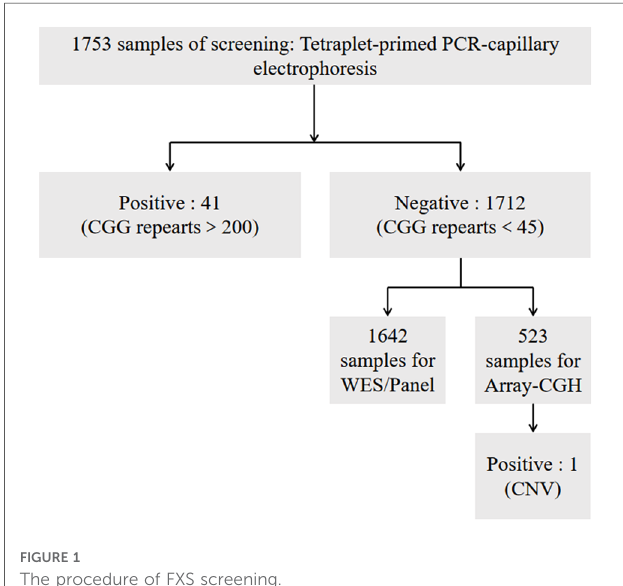
FIGURE 1 The procedure of FXS